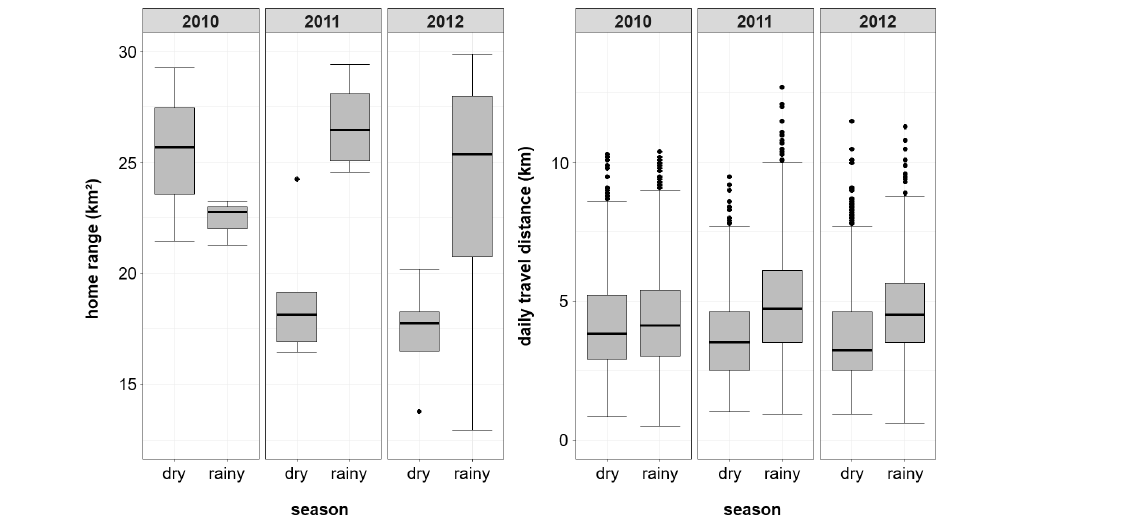
Figure 8. Annual and seasonal variation in home range and daily travel distance (DTD). Boxplots depict the median (black line) and the IQR with the lower (25%) and upper (75%) quartile. Boxplot whiskers represent the 1.5 IQR of the lower and upper